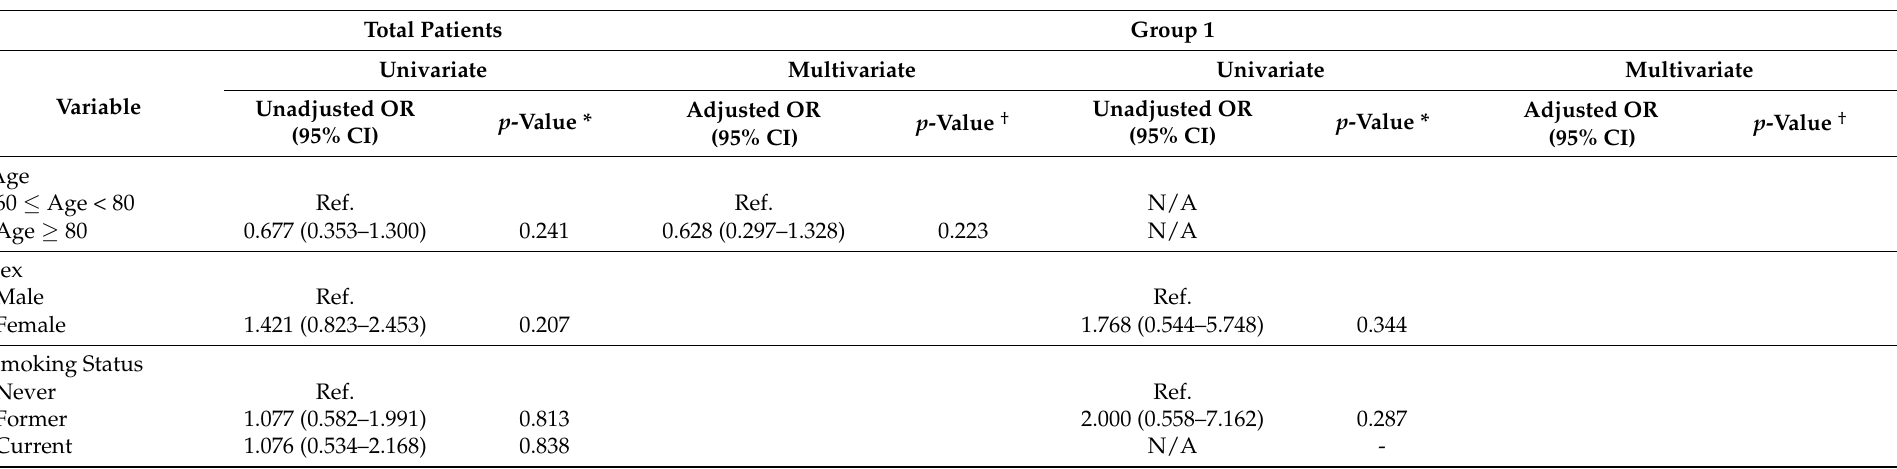
Table 6. Risk factors of overall complications of CT-guided PTNB in total patients and Group 1